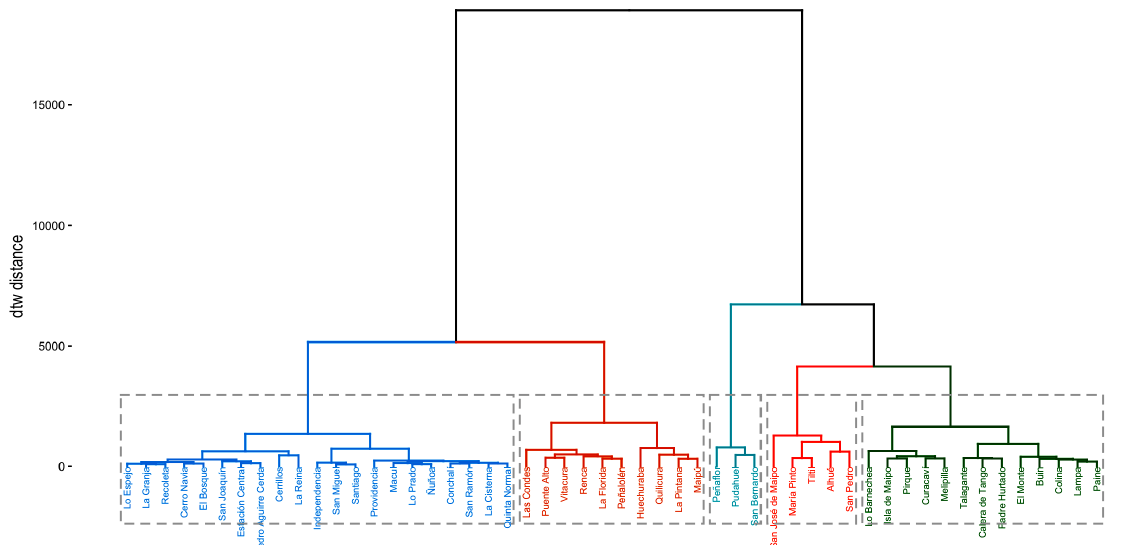
Figure 3. Hierarchical clustering using DTW for mobility time series. The solution with five clusters is